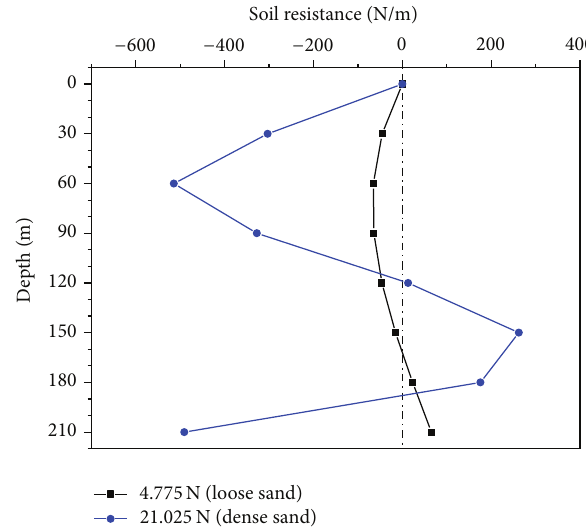
Figure 3: Comparison of the bending moment in loose and dense sand.